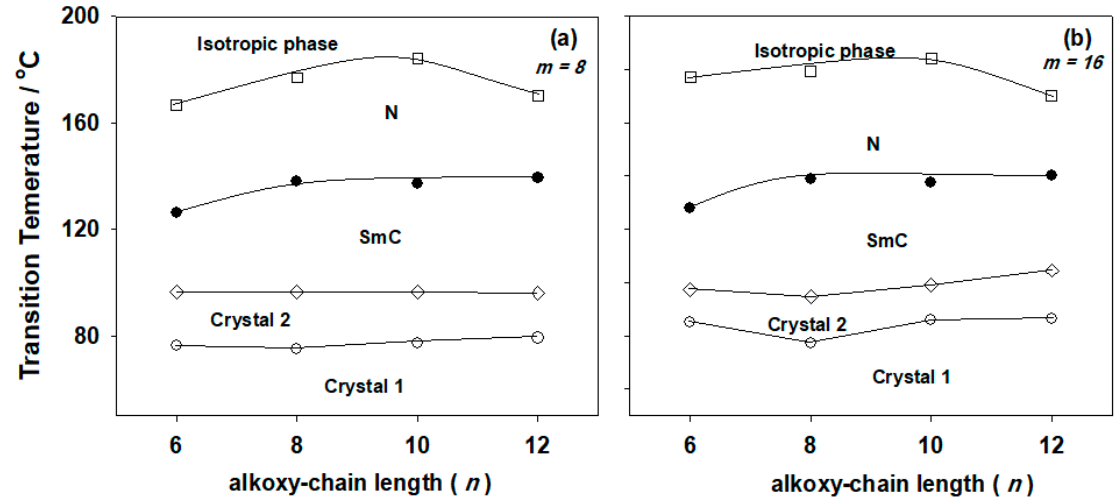
Figure 1. Effect of the alkoxy-chain length ( n ) of the azopyridine derivatives ( II m ) on the mesophase behavior of the 1:1 supramolecular hydrogen-bonded complexes ( a ) m = 8; ( b ) m = 16.